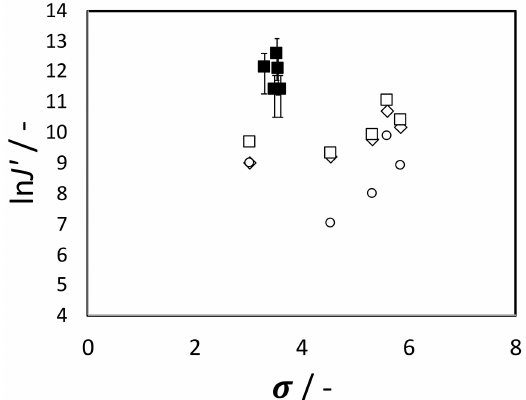
Figure 1. Natural logarithm of apparent nucleation rates ln J (cid:48) with supersaturation σ . White and black squares indicate ln J (cid:48) calculated using the total number of crystals nucleated in V obs under microgravity and on the ground, respectively. White diamonds and circles indicate ln J (cid:48) on the substrate and in the solution,